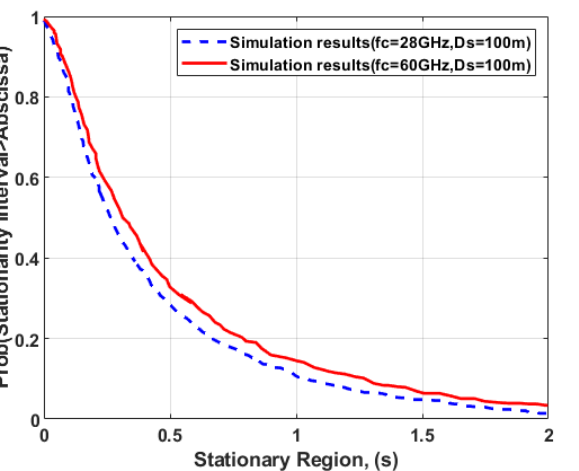
Figure 10. Simulated CCDF of the stationary interval for different mmWave frequencies.